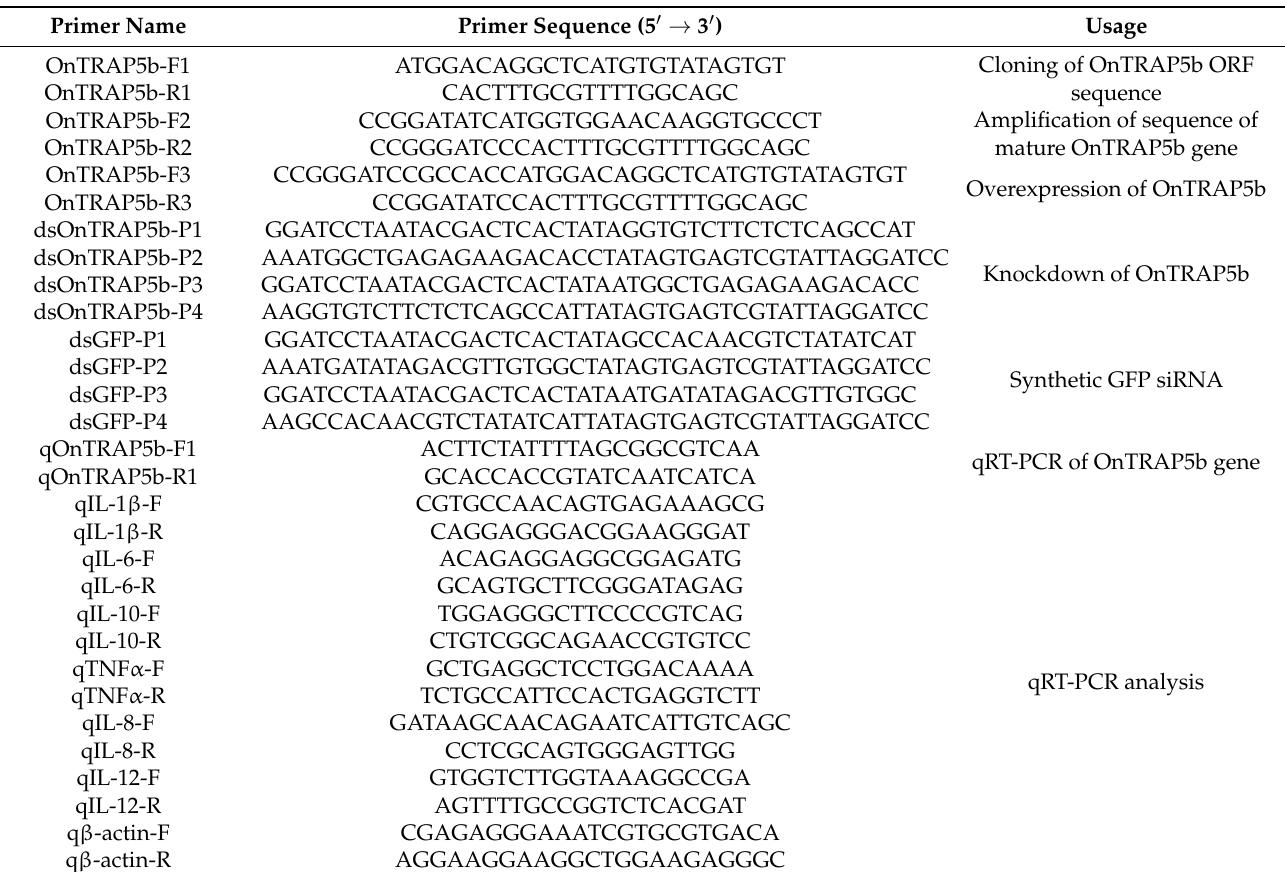
Table 1. Primers used in this